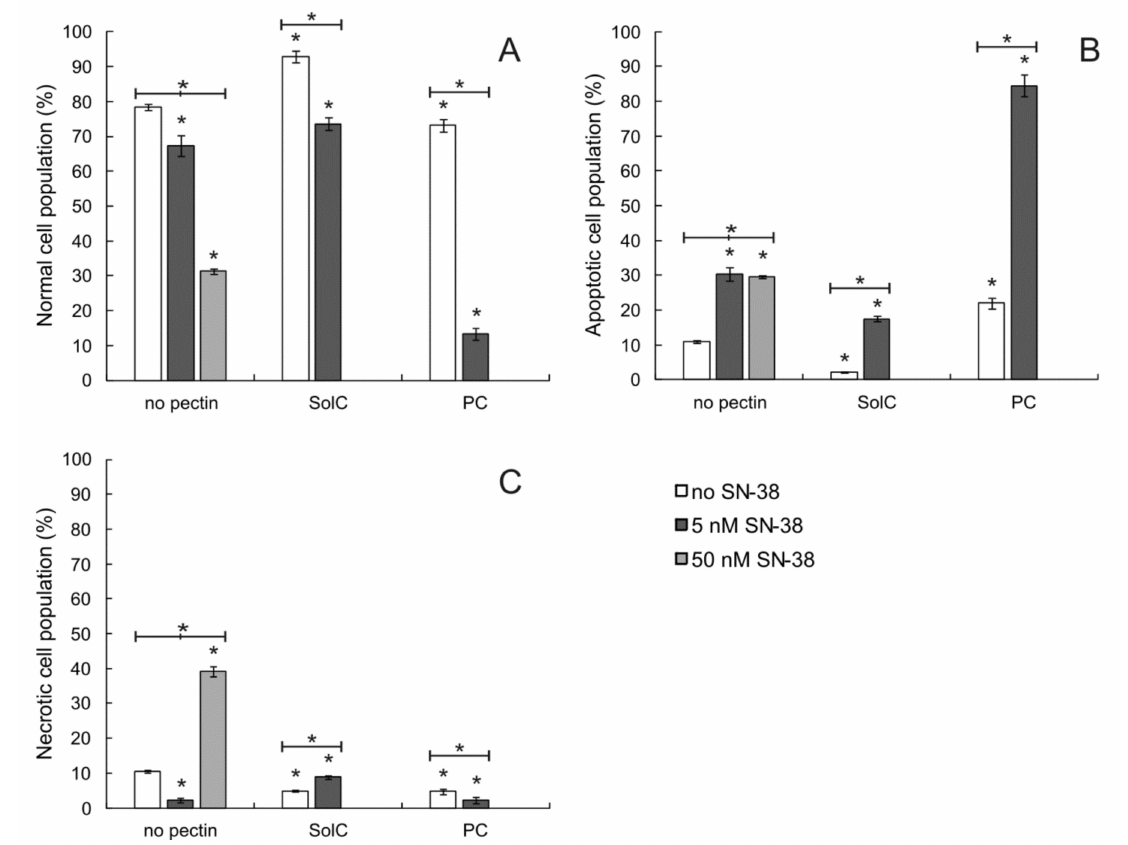
Figure 2. The proportion of normal ( A ), apoptotic ( B ), and necrotic ( C ) cell populations as recorded by Annexin-V apoptosis assay in HCT 116 cells treated with pectins (0.2 mg/mL) and/or SN-38 for 48 h. The means of three experiments ± SD are presented (* p < 0.05). Statistical significance was checked between the studied probes and controls (no pectin), and between probes containing only pectin and pectin combined with SN-38. Cells were recognized as viable (Annexin-V and PI negative), apoptotic (Annexin-V positive and PI negative), and necrotic (Annexin-V and PI positive) based on the measurement of cell-associated fluorescence of FITC-Annexin-V conjugate and